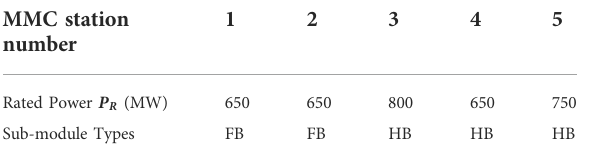
TABLE 3 MMC parameters.